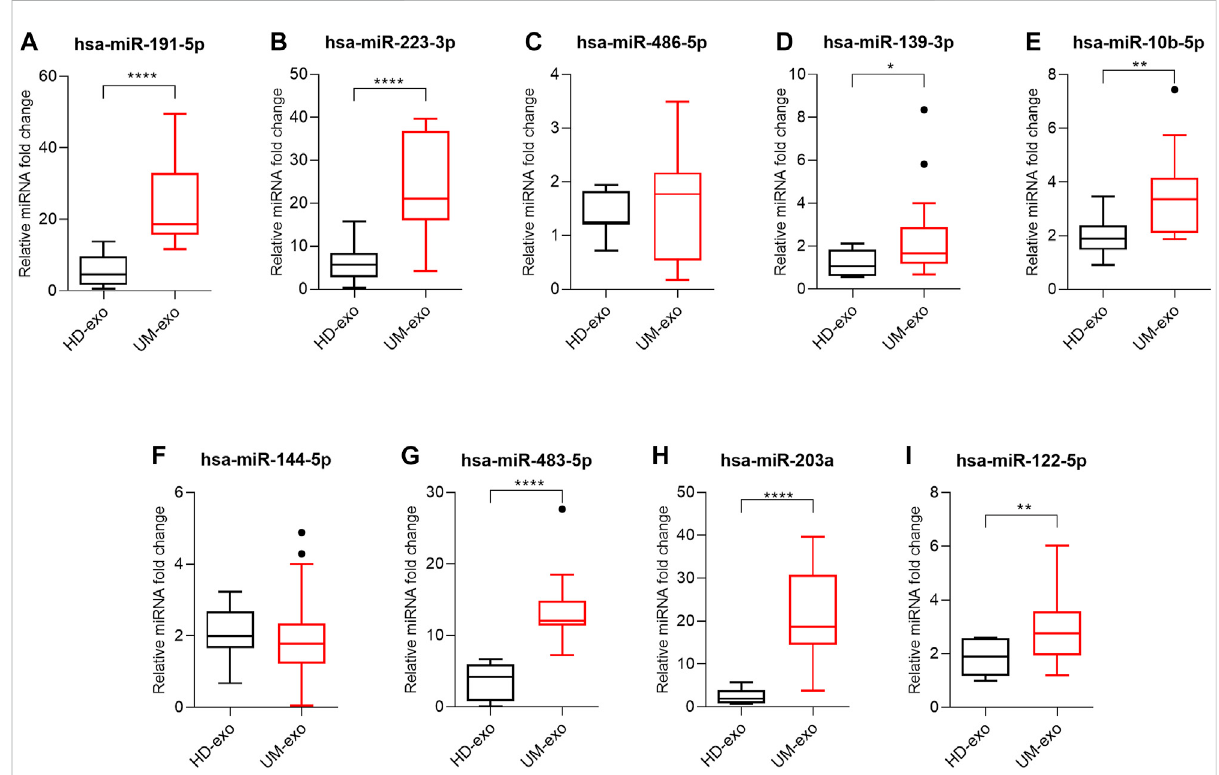
FIGURE 4 Real-time qPCR analysis of hsa-miR-191-5p (A) , hsa-miR-223-3p (B) , hsa-miR-486-5p (C) , hsa-miR-139-3p (D) , hsa-miR-10b-5p (E) , hsa- miR-144-5p (F) , hsa-miR-483-5p (G) , hsa-miR-203a (H) , hsa-miR-122-5p (I) in exosomes derived from healthy donors (HD-exo, n = 20) and patientswithuvealmelanoma(UM-exo, n =20),regardlessofthestageofdisease.TheresultsaredisplayedasrelativemiRNAfoldchangecalculated as log2- ΔΔ Ct. Data were normalized to an exogenous spike-in control (hsa-miR-6351-5p mimic). The graph represents median ±SD, outliers aremarkedasdots.Thestatisticaldifferencesbetweenthetwogroupswereanalyzedwitheither t -testwithWelchcorrection(forsamplesfollowing Gaussian distribution) or Mann-Whitney test (for samples not following Gaussian distribution), where: * p < 0.05, ** p < 0.01, *** p < 0.001, **** p <